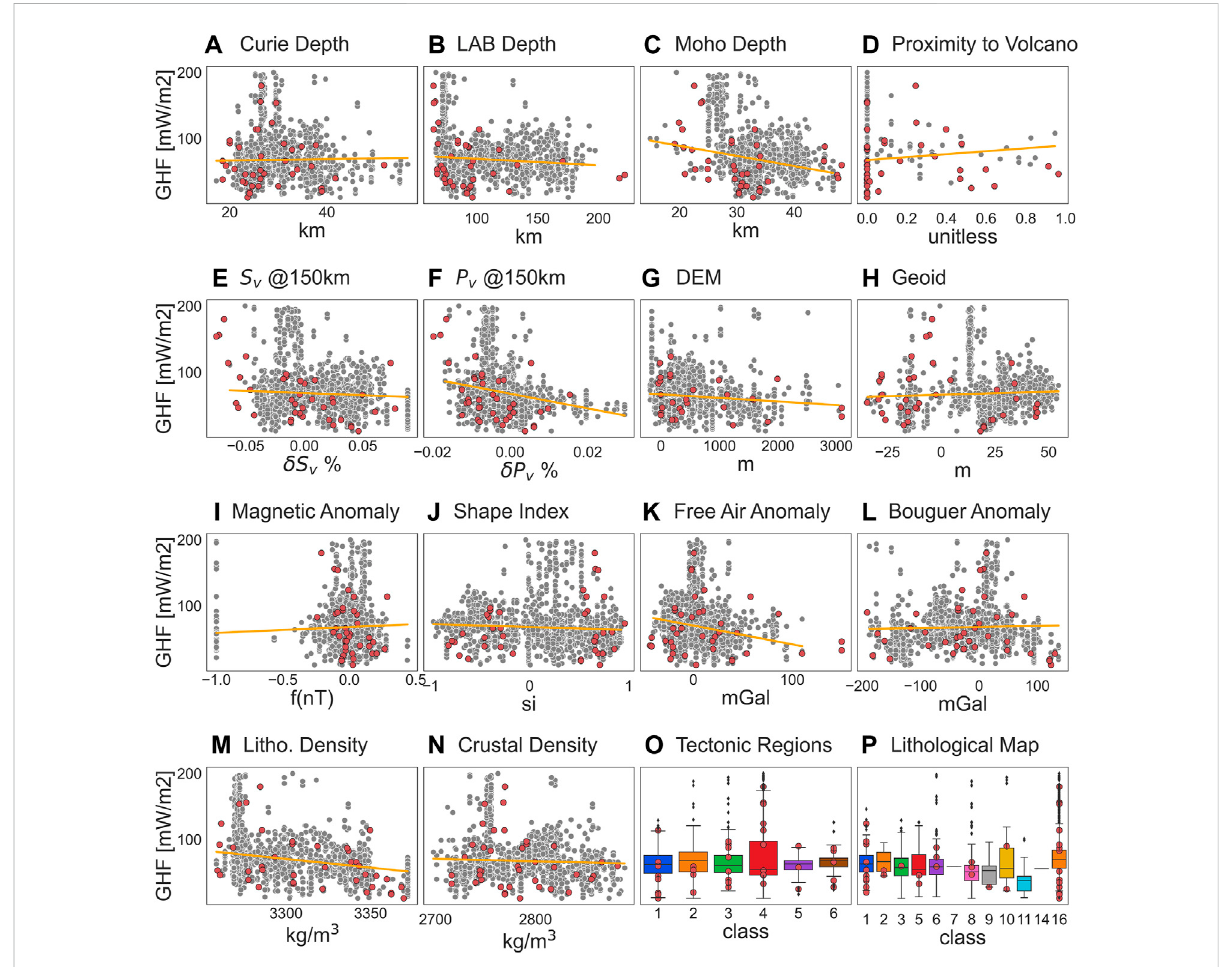
FIGURE 2 Cross plots of the GHF measurements against geological and geophysical observables; the orange lines indicate the linear regression results. Categorical observables are illustrated by boxplots. Red dots indicate outliers. Classes for tectonic regionalizations refer to: 1 = Cratons; 2 = Precambrian Fold Belts and Modi fi ed Cratons; 3 = Phanerozoic Continents; 4 = Ridges & Backarcs; 5 = Oceanic; 6 = Oldest Oceanic. Classes for GLIM inside Africa refer to: 1 = Unconsolidated sediments; 2 = Siliciclastic sedimentary rocks; 3 = Pyroclastics; 5 = Carbonate sedimentary rocks; 6 = Evaporites; 7 = Acid volcanic rocks; 8 = Intermediate volcanic rocks; 9 = Basic volcanic rocks; 10 = Acid plutonic rocks; 11 = Intermediate plutonic rocks; 14 = Water Bodies; 16 = No